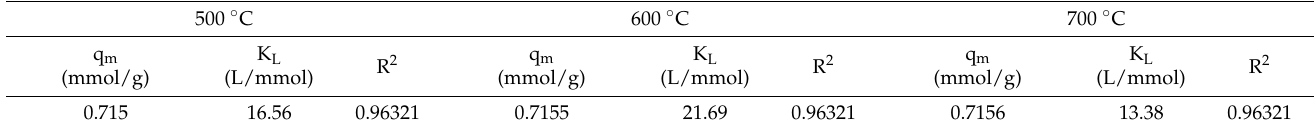
Table 5. Isotherm parameters calculated from Langmuir model.